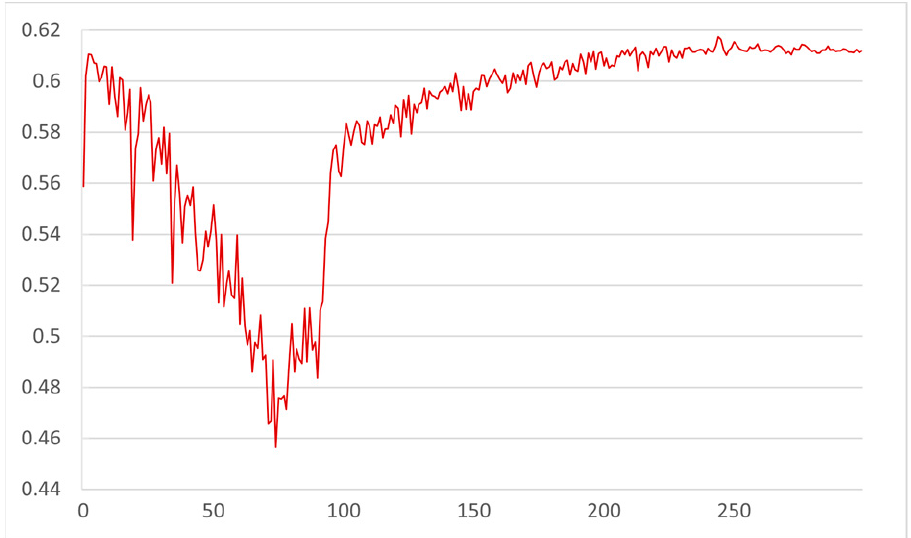
Figure 9. Variation in model accuracy during sparse training.